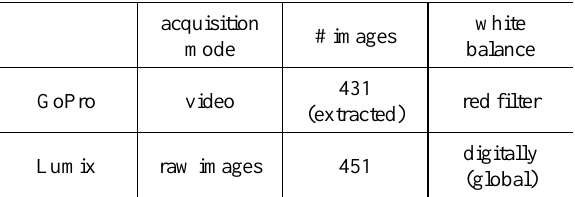
Table 1. GoPro and Lumix dataset acquisition details. GoPro images were extracted from the video sequence at a constant time rate